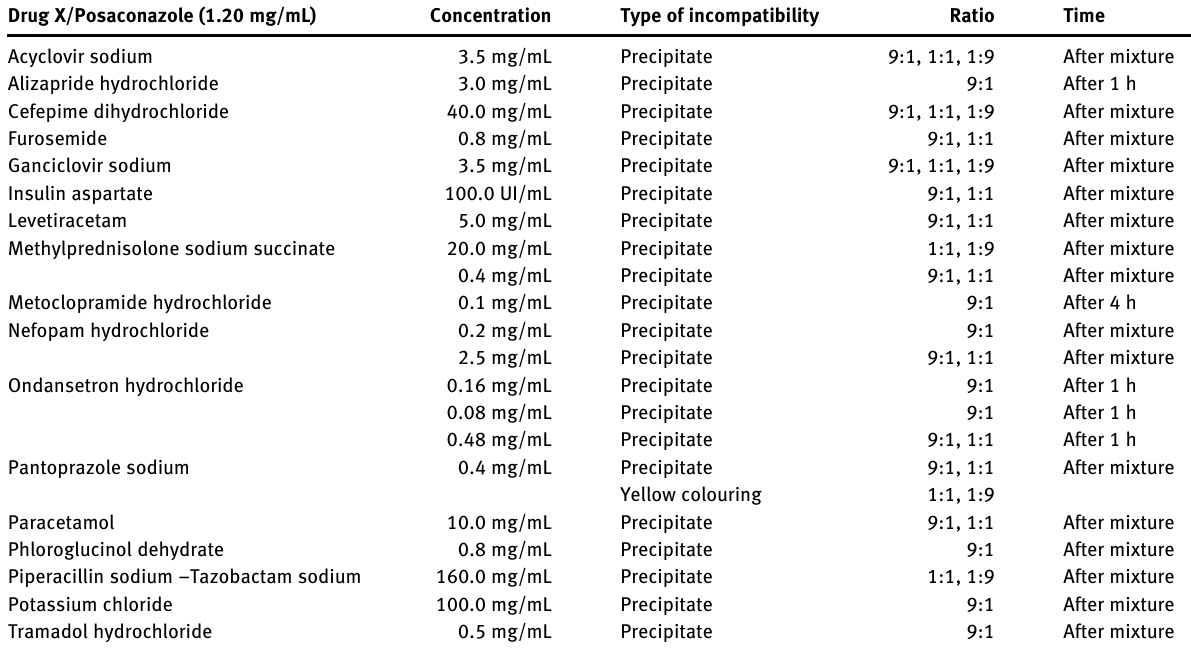
Table  : Final ratio results with physical modi fi cation after  -h storage. Drug X/Posaconazole (  . 